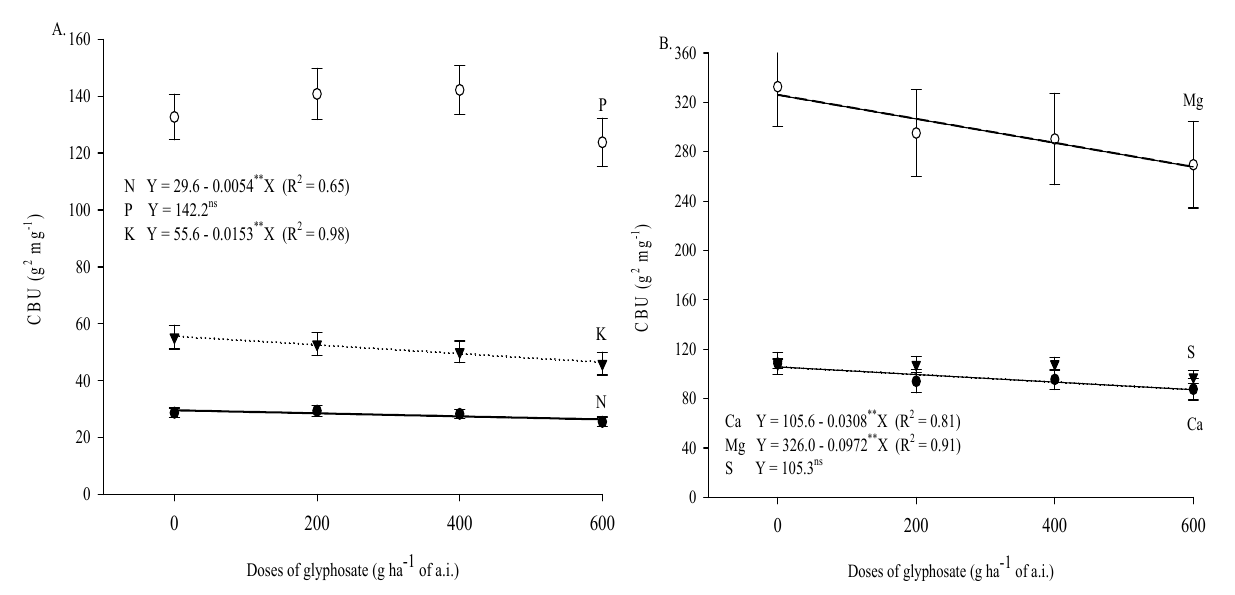
Figure 4. Coefficient of the biological utilization (CBU) of N, P and K ( A ), Ca, Mg and S ( B ) of emerald grass as a function of doses of glyphosate. The letters correspond to a significant difference at the 5% probability level ( p ≤ 0.05). ns and **: not significant and significant at p < 0.01, respectively. Error bars indicate the standard deviation of the mean ( n = 4).